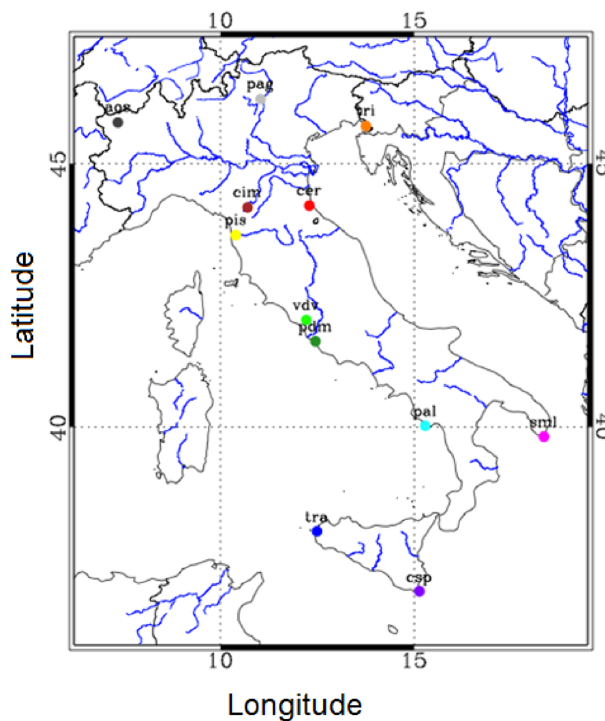
Figure 2. Stations distribution over the Italian territory.